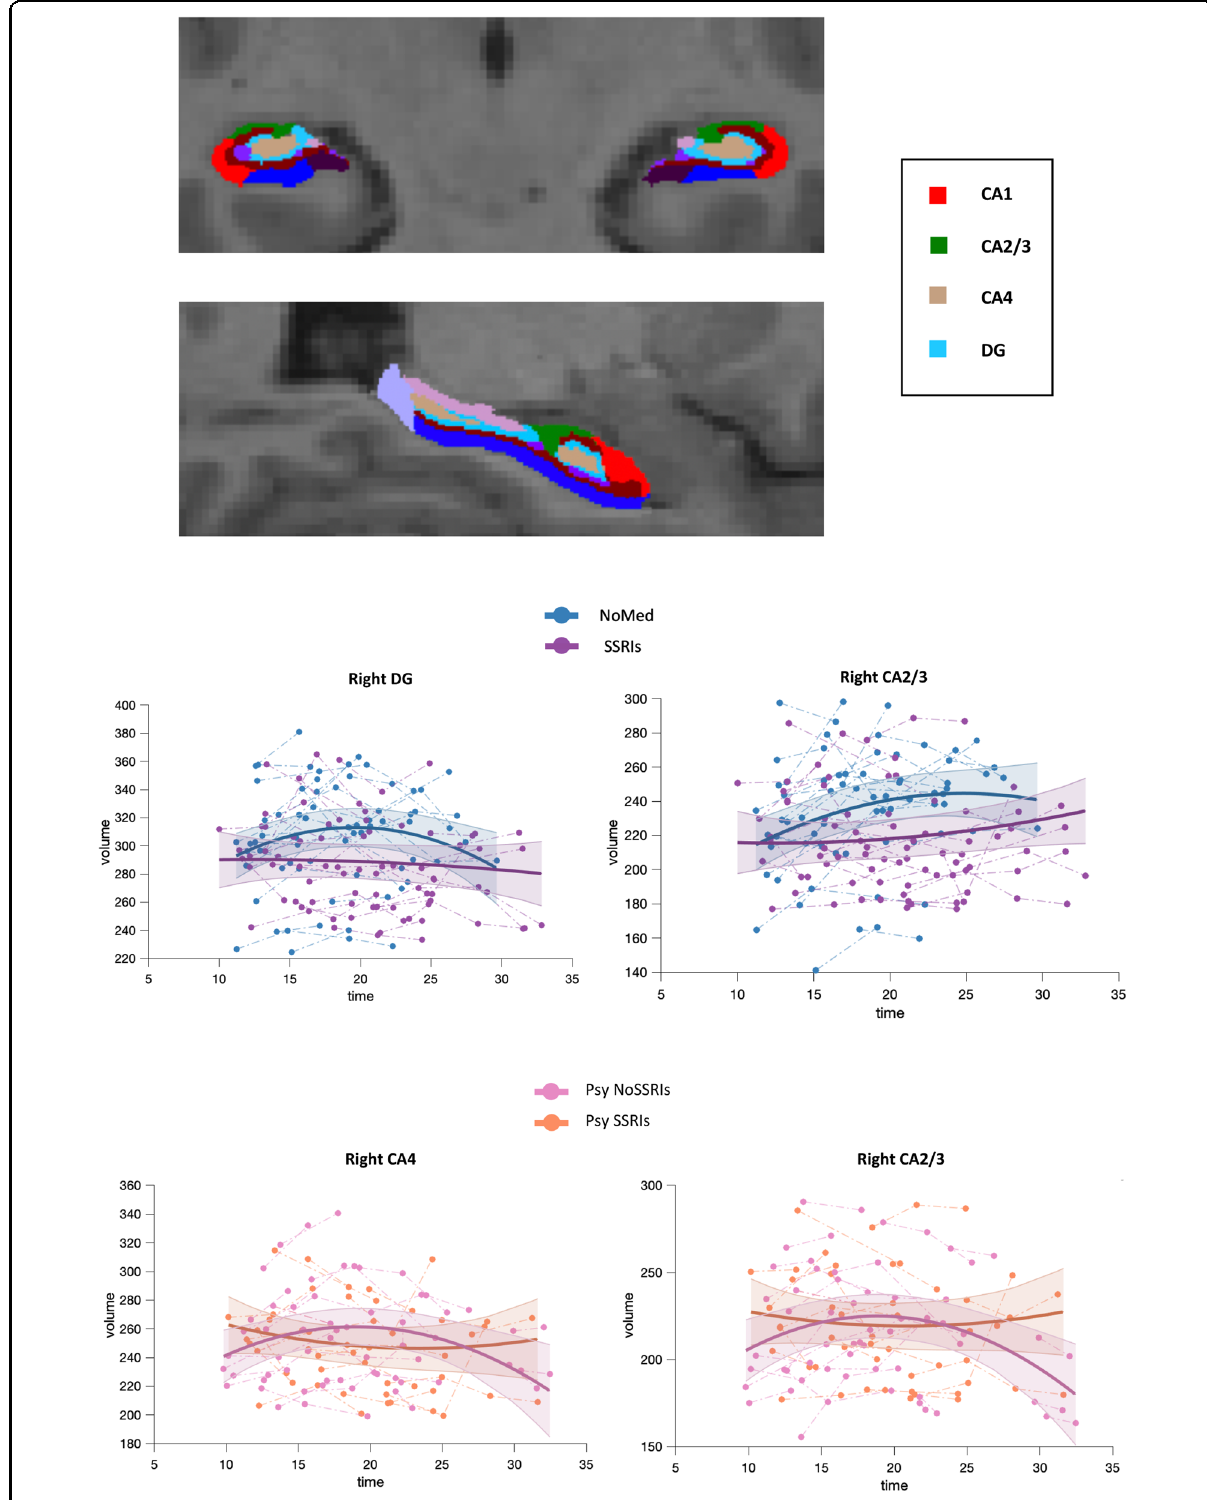
Fig. 2 Hippocampal volume trajectories. Developmental trajectories of hippocampal sub fi elds (CA4, CA3, CA4) in deletion carriers with and without treatment with SSRIs (upper panel) and deletion carriers endorsing psychotic symptoms with and without treatment with SSRIs (lower